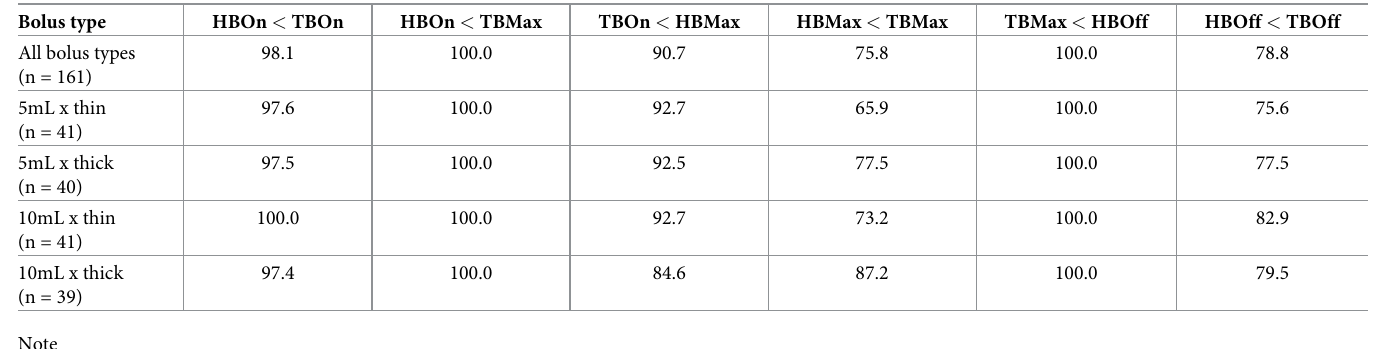
Table 4. Percentage adherence to the anticipated sequence of paired-events. Bolus type